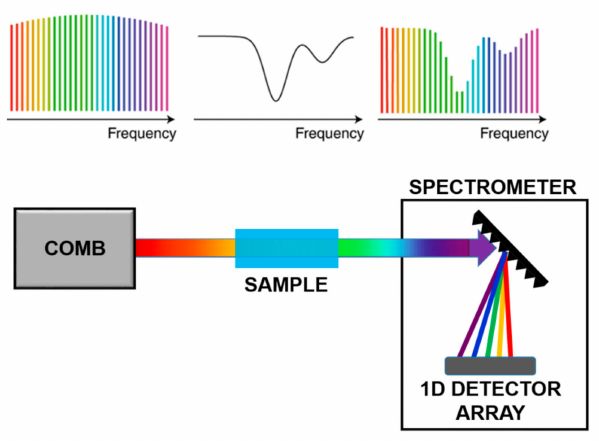
Figure 6. Scheme of Direct Comb Spectroscopy. Adapted with permission from [68], copyright